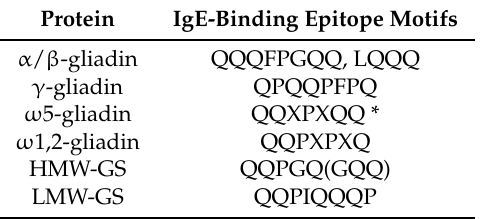
Table 4. Currently identified IgE-binding epitopes in wheat gluten proteins. *—X—any amino acid. Protein IgE-Binding Epitope